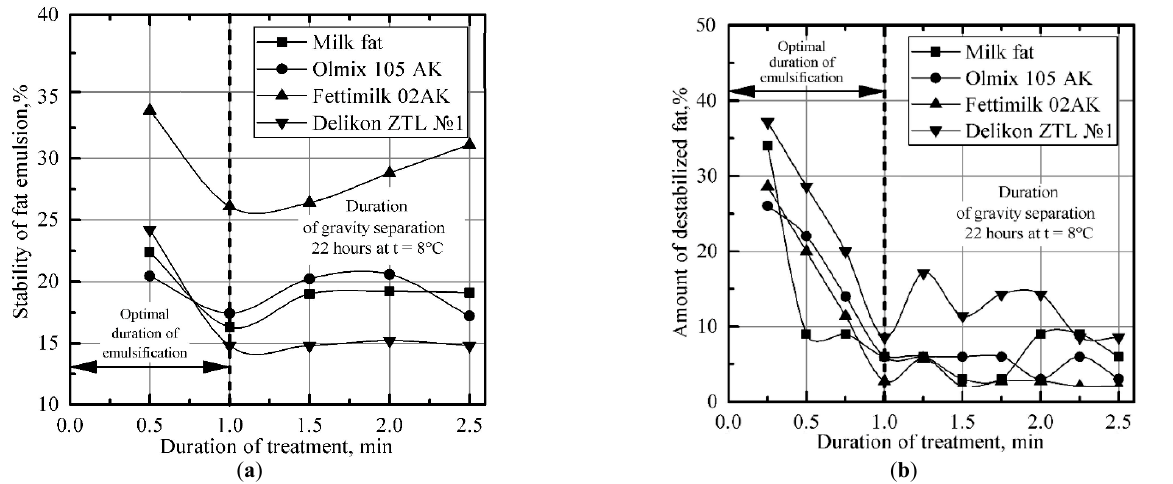
Figure 9. Variance in fat emulsion stability during treatment in the emulsification device (concentration of surfactant 0.6%: monoglycerid + lecithin in the ratio of 3:1): ( a ) stability of fat emulsion; ( b ) amount of destabilized fat.